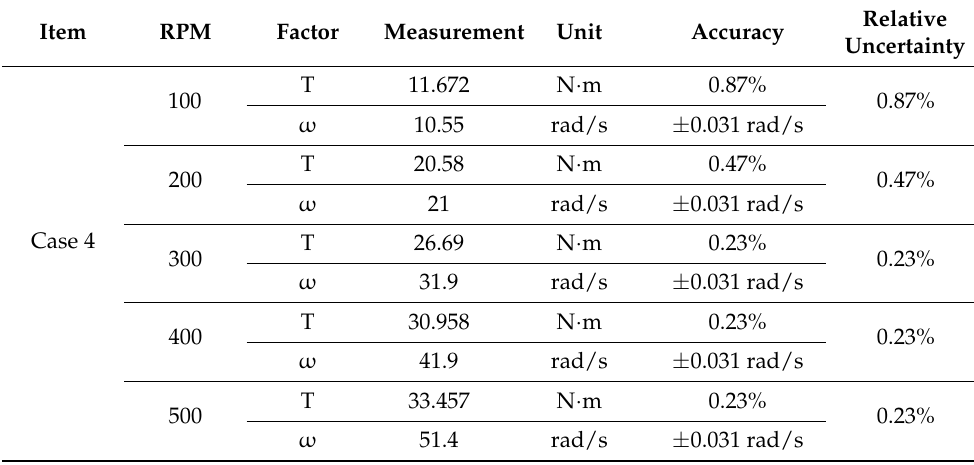
Table 7. Relative uncertainty of case 4 in terms of output